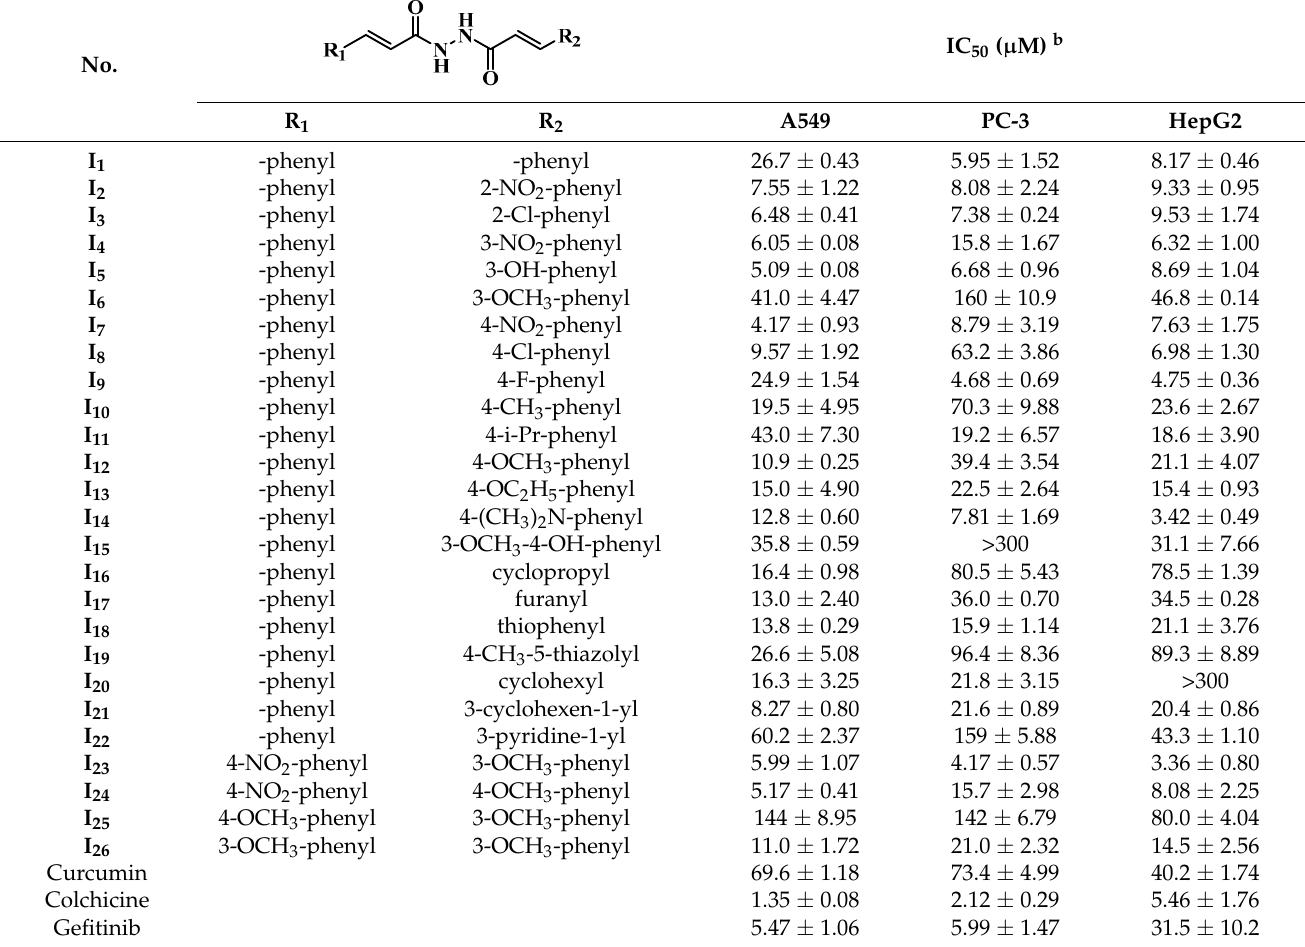
Table 1. The antiproliferative activity of all designed compounds against cancer cell lines a .